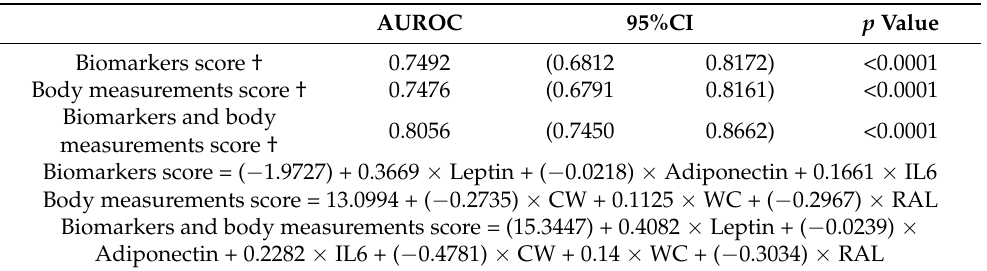
Figure 1. The receiver operating characteristic (ROC) curves to predict CAD. Table 6. Area under the receiver operating characteristic curve (AUROC) and 95% confidence interval (CI) for the different scores.